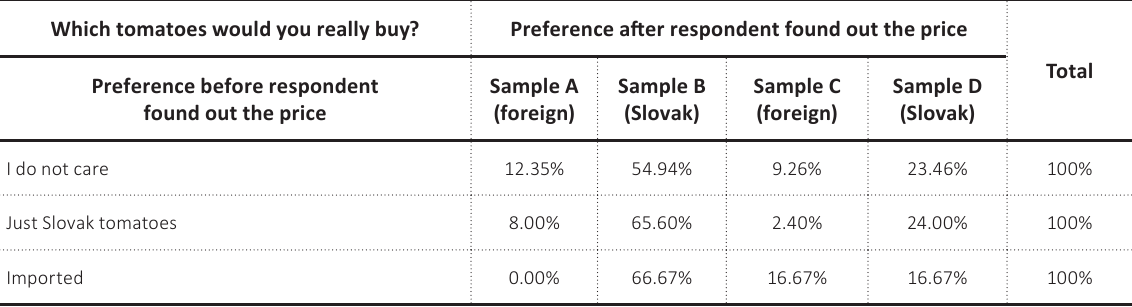
Table 3. Change of preferences before and after finding out the price